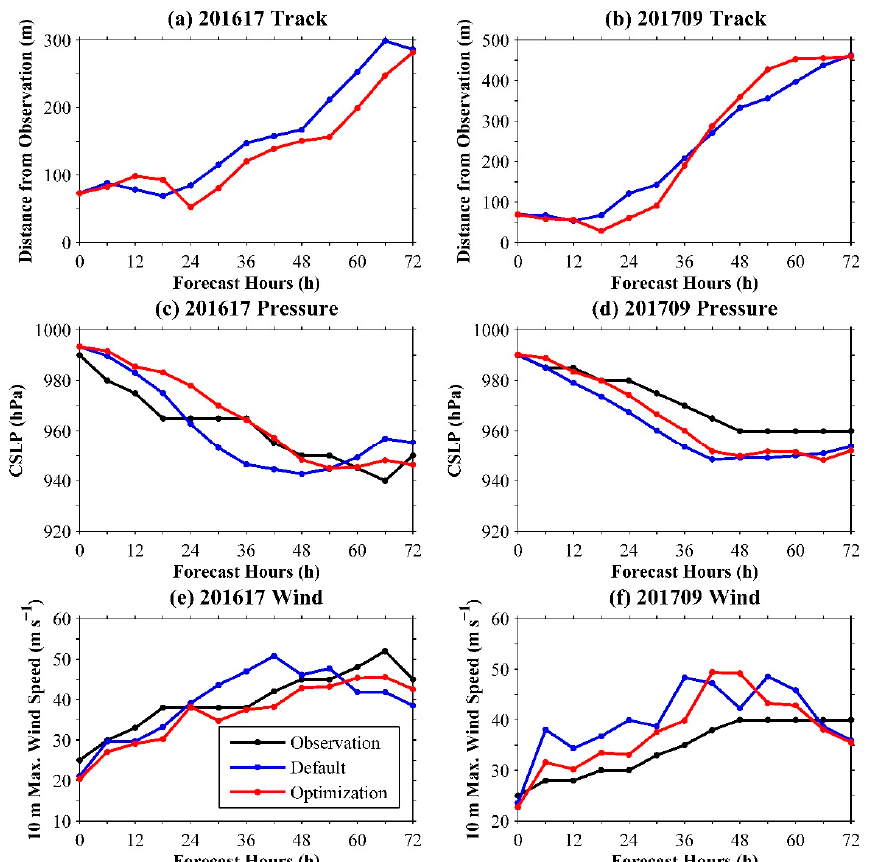
Figure 10. Comparisons of the track and intensity simulations for typhoon Megi (201617) and typhoon Nesat (201709) using the default and optimal scheme combinations. ( a , b ), ( c , d ), and ( e , f ) represent the comparisons of the track, CSLP, and 10-m wind simulations, respectively. The observations are also from the CMA-STI best track dataset for tropical cyclones over the Northwest Pacific Ocean.